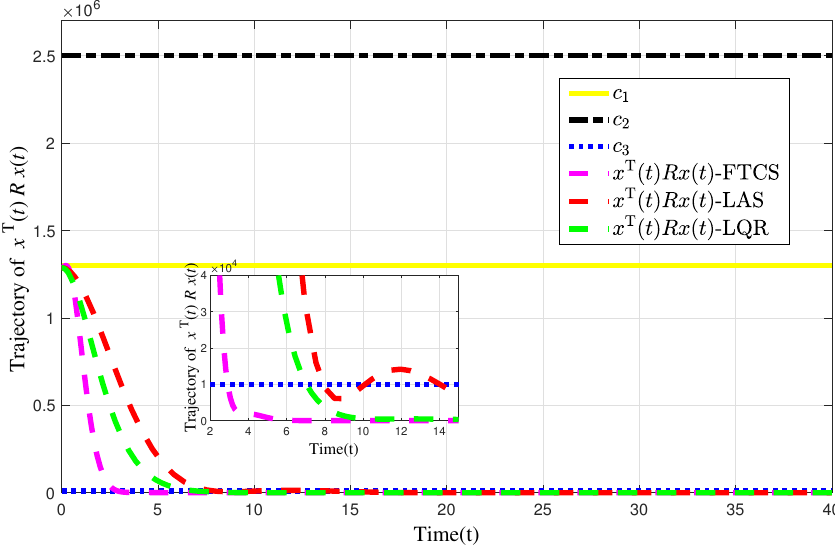
Figure 2. Evolution of x T ( t ) Rx ( t ) under different control